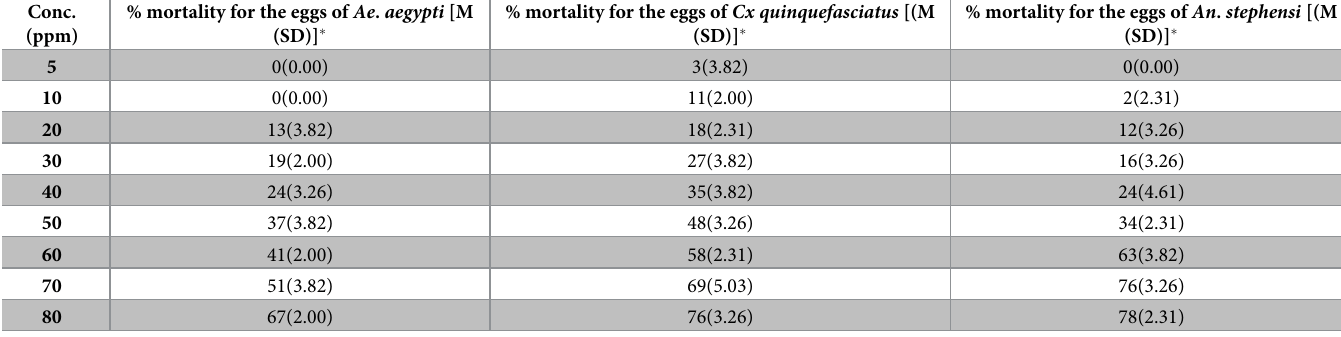
Table 2. Ovicidal activity of AgNPs synthesized by Bacillus marisflavi against the eggs of Ae . aegypti , Cx . quinquefasciatus and An . stephensi . Conc. % mortality for the eggs of Ae . aegypti [M (ppm) (SD)]